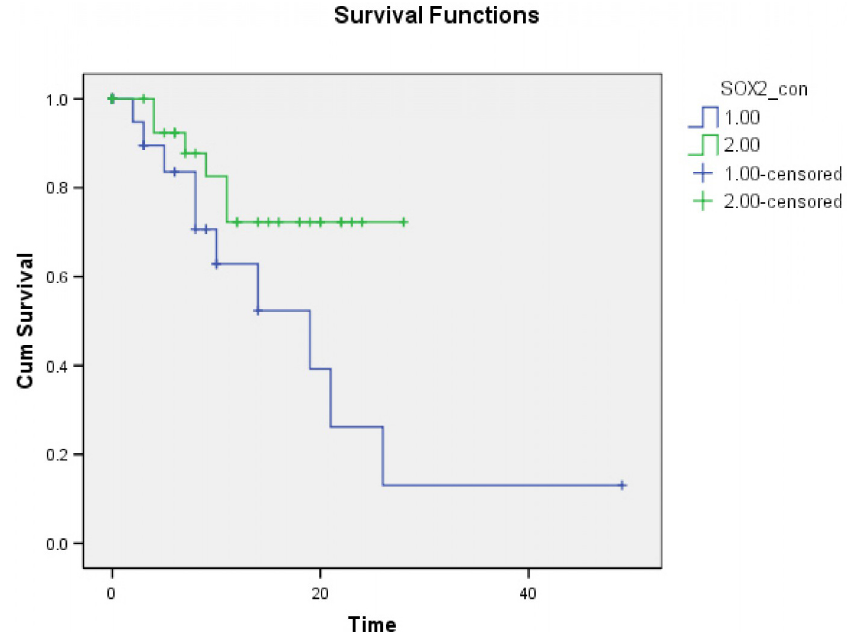
Figure 5- Kaplan–Meier survival plots showing a significant difference in the clinical behavior of the tumors. Tumors with a low expression of SOX2 (blue line) had shorter disease free survival time compared to tumors with a high expression of SOX2 (green